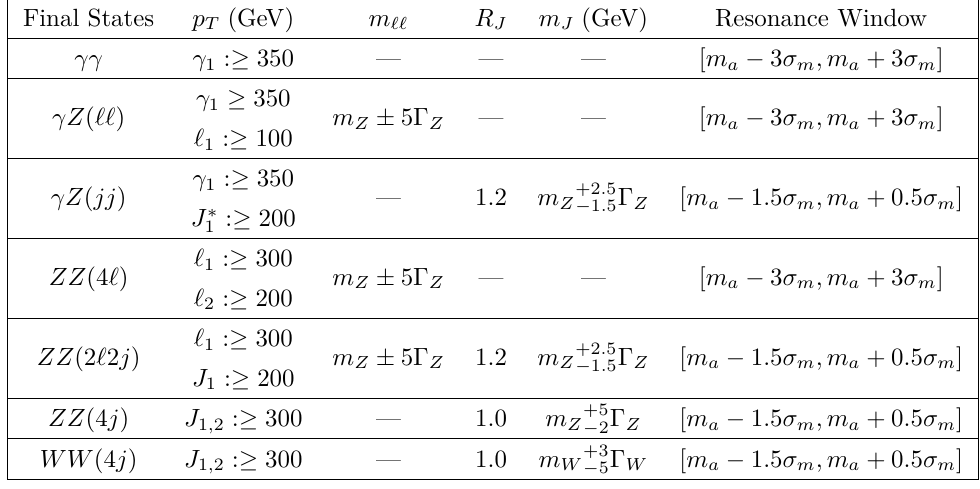
Table 2 . Detector-level cuts imposed on various analyses: — means that no value is applicable; J represents a detector-level fat jet, while j corresponds to a parton-level jet. The subscript of a particle name denotes its detector-level p T ordering. The jet radius R = 1 is used for final states with two J ’s (corresponding to 4 j ’s), and R = 1 . 2 is used for final states with one J ( 2 j ’s). The superscript ∗ indicates that the requirement is only for fat jets that do not contain photons. The width of each resonance peak is characterized by σ m , see the main text for more